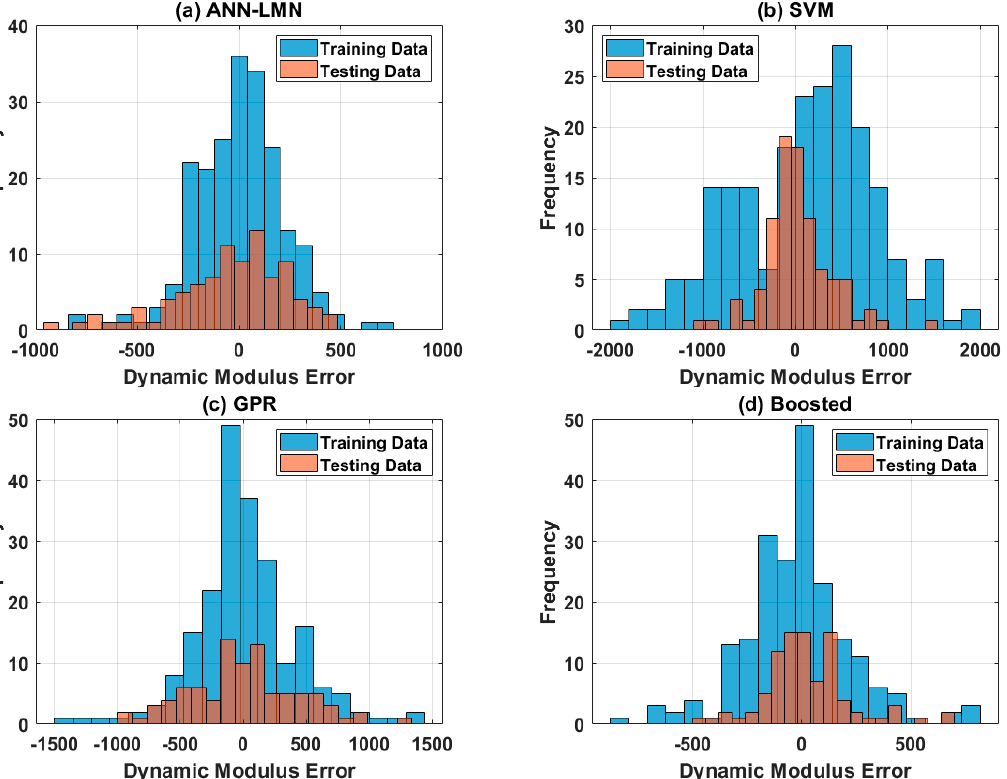
Figure 6. Graphs of error frequency between the predicted and experimental values for ( a ) ANN-LMN, ( b ) SVM, ( c ) GPR, and ( d ) Boosted.